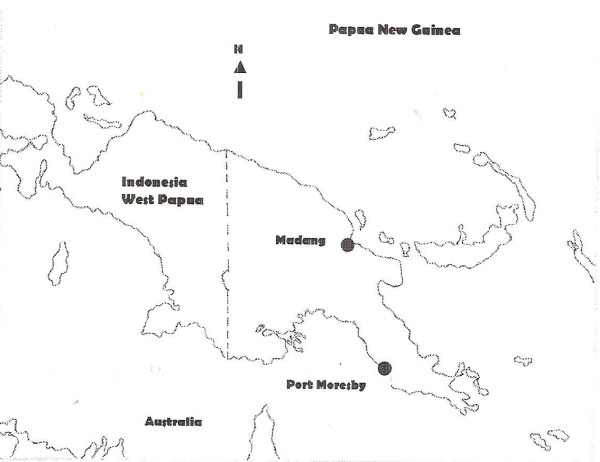
The map of Papua New Guinea showing the locations of the study in the two regions.